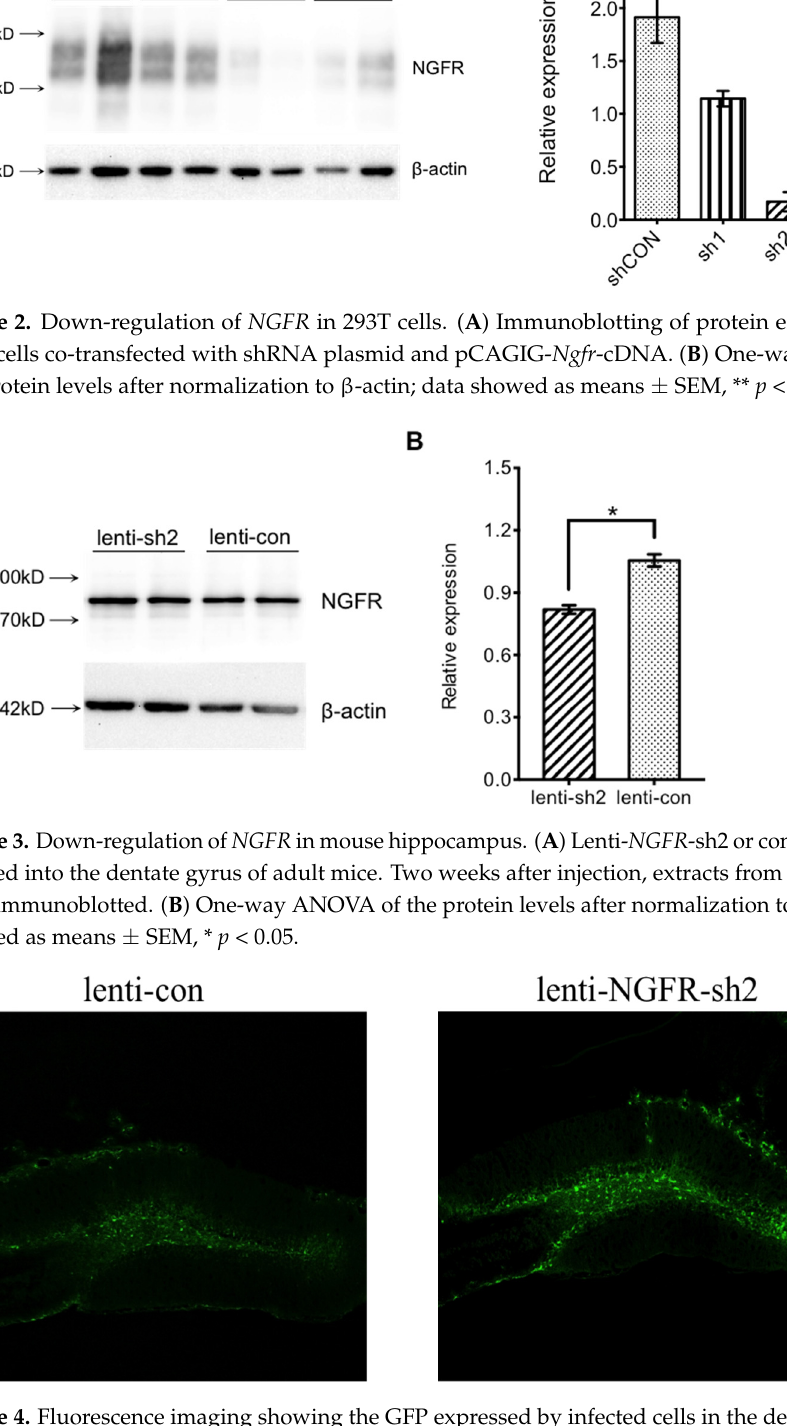
Figure 4. Fluorescence imaging showing the GFP expressed by infected cells in the dentate gyrus of adult mice.